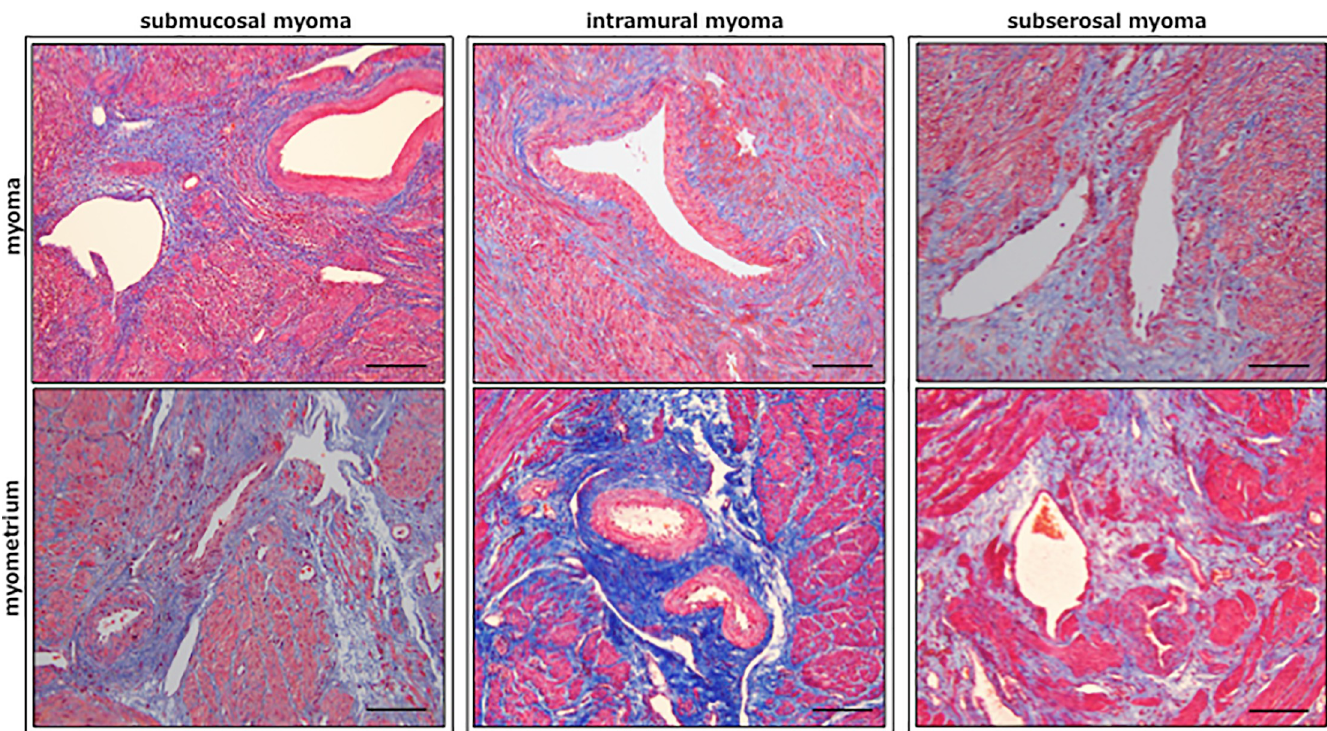
Fig 7. The distribution of Masson’s trichrome (MT)-stained perivascular fibrosis in the biopsy samples derived from myoma (upper row) and myometria (lower row) of women with submucosal myoma (SMM, left column), intramural myoma (IMM, middle column) and subserosal myoma (SSM, right column). A variable distribution of dense fibrosis was observed around the small size and large size vessels in the myoma and myometria derived from women with SMM, IMM and SSM. Scale bar = 50 μ m for each slide.